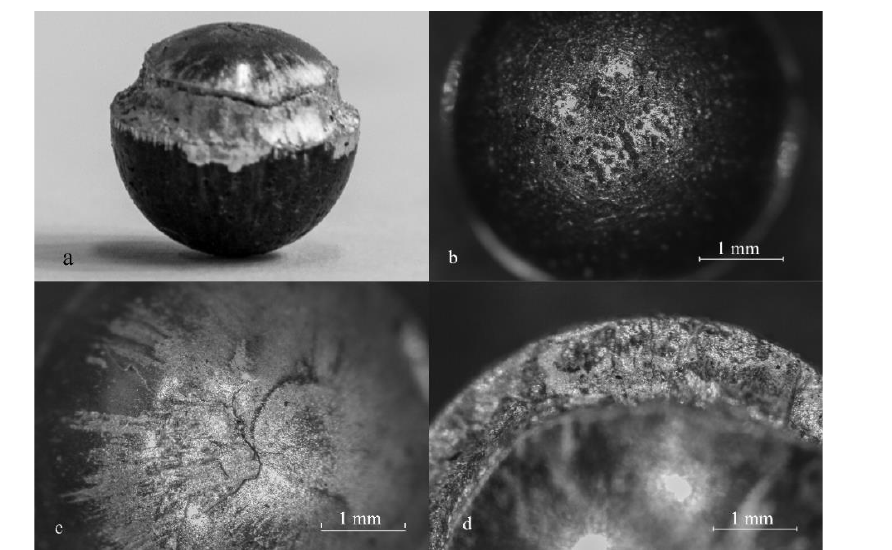
Fig. 7 Collection of photographs showing, a) damaged ball bearing after a 5.13 g detonation, b) magnified top view of Face B of the bearing in a, c) magnified top view of the Face A, d) magnified view of the fragmented